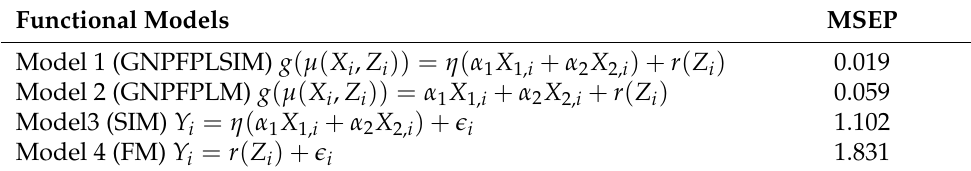
Table 13. The MSEPs for different models: Gaussian case.